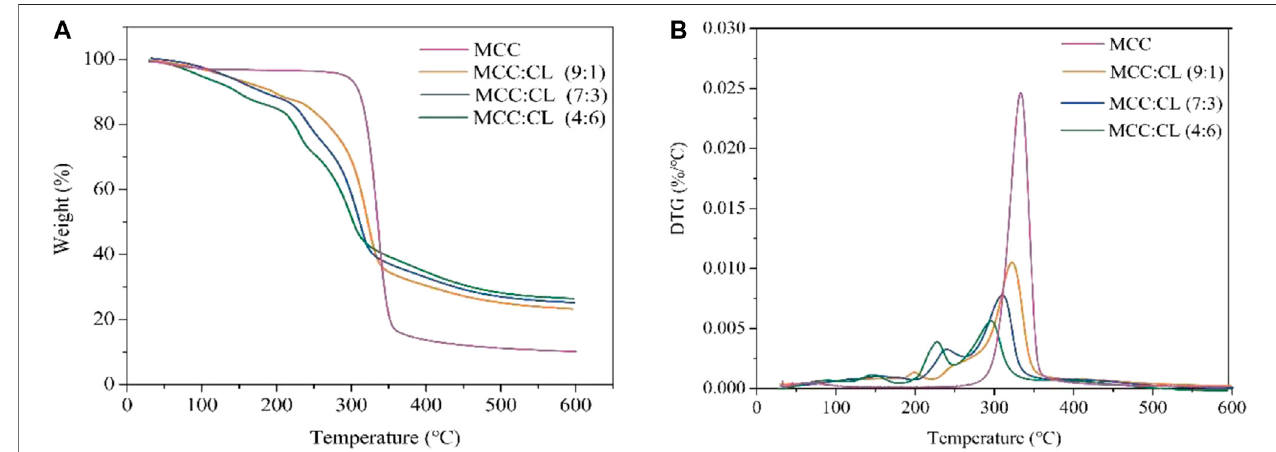
FIGURE 9 | Typical TGA and DTG curves for the MCC fi lm and MCC:CL biocomposite fi lms.